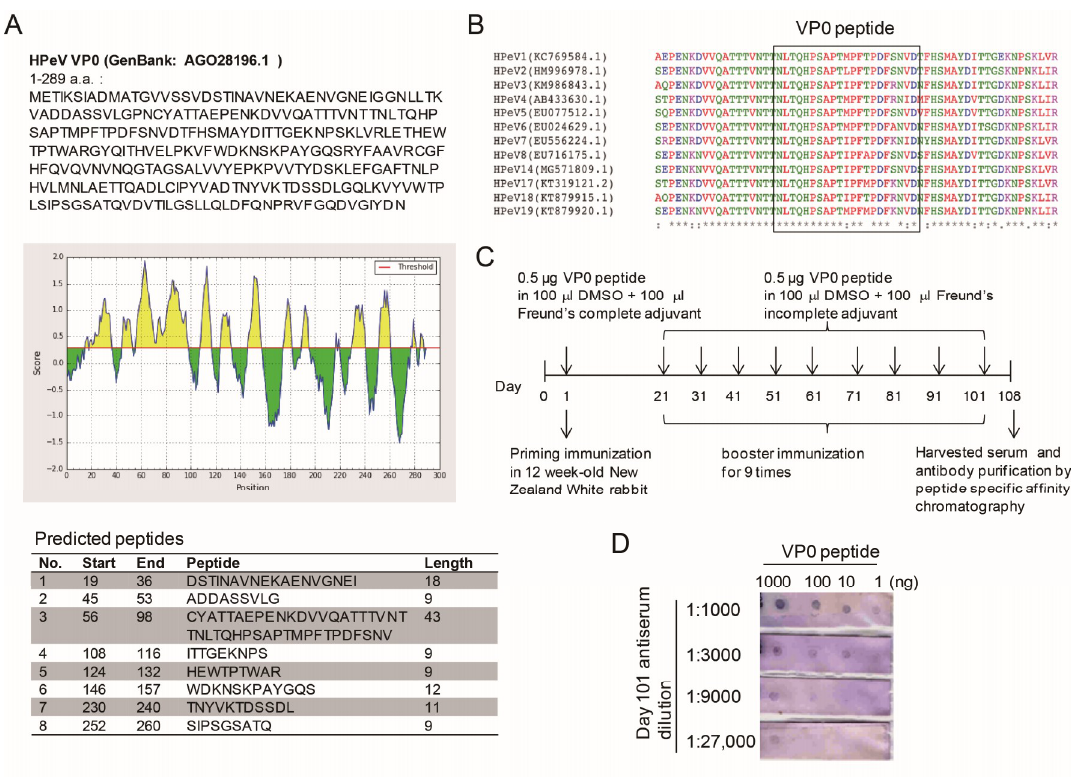
Figure 1. Epitope analysis and antibody production. ( A ) The 289 amino acid-polypeptide sequence of parechovirus A (Human parechovirus type 1, HPeV1) VP0 (Genbank: AGO28196.1) was used to predict an epitope by using the Bepipredlinear epitope prediction method (IEDB analysis resource, http://tools.immuneepitope.org/bcell/ or http://www.cbs.dtu.dk/services/BepiPred/). The eight-peptide sequence with antigenicity was shown. ( B ) Multiple sequence alignment of HPeV type 1-8, 14 and 17-19 VP0 peptides involved use of Clustal Omega, https://www.ebi.ac.uk/Tools/msa/clustalo/. The VP0 available in NCBI Genbank for analysis. ( C ) Schematicfor anti-HPeV VP0 antibody generation. ( D ) Antibody titration (dilution ranging 1:1000~1:27,000) of the anti-serum was measured by dot blotting with 1 to 1000 ng VP0 peptide spotted.